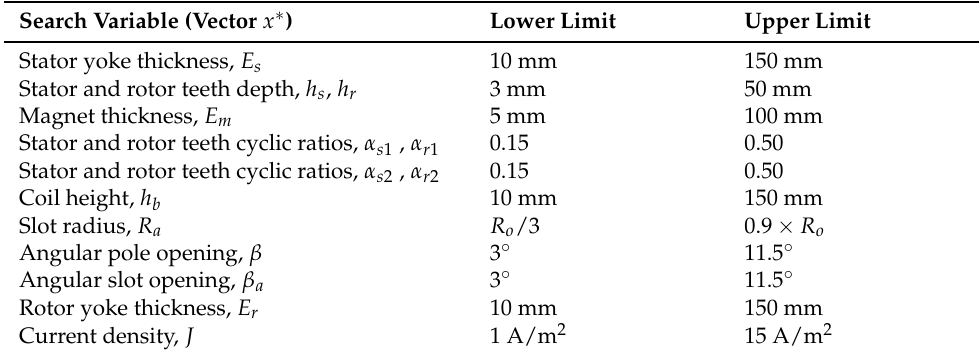
Table 3. Design variables and respective